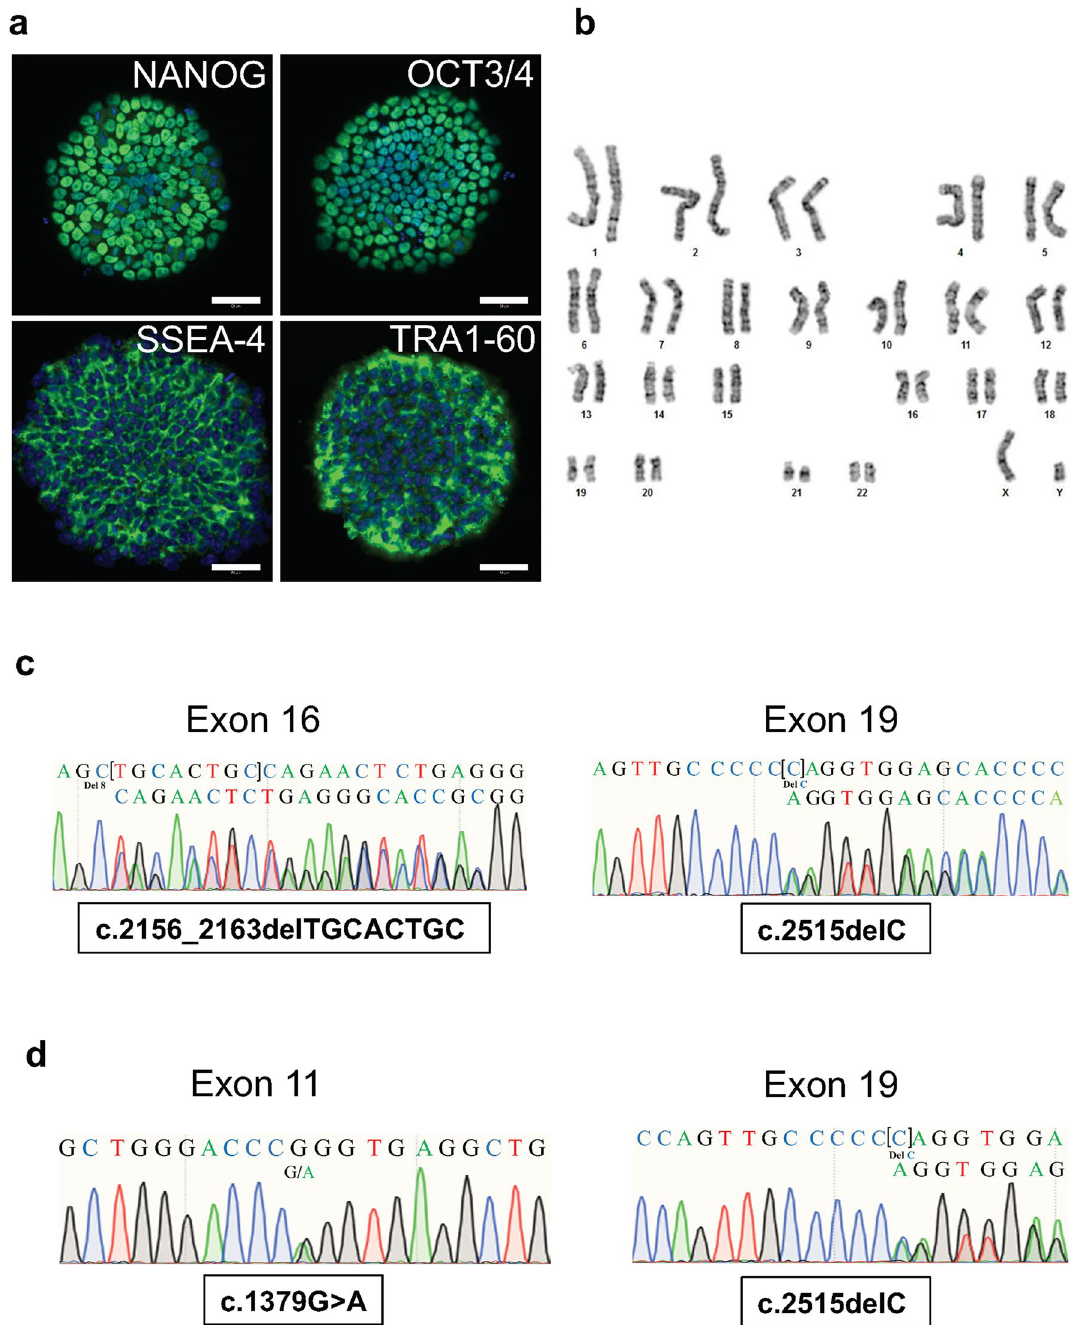
Figure 3. Establishment of iPSCs from the two patients with NPHS1 mutations. ( a ) Stem cell markers expressed in the patient-derived iPSCs. Representative data for clone Pt3-32 are shown. The other three clones showed comparable results. Scale bars: 50 µm. ( b ) Normal karyotype (46, XY) in the patient-derived iPSCs (Pt-3–32). ( c ) NPHS1 sequences in Patient 1-derived iPSCs. ( d ) NPHS1 sequences in Patient 3-derived